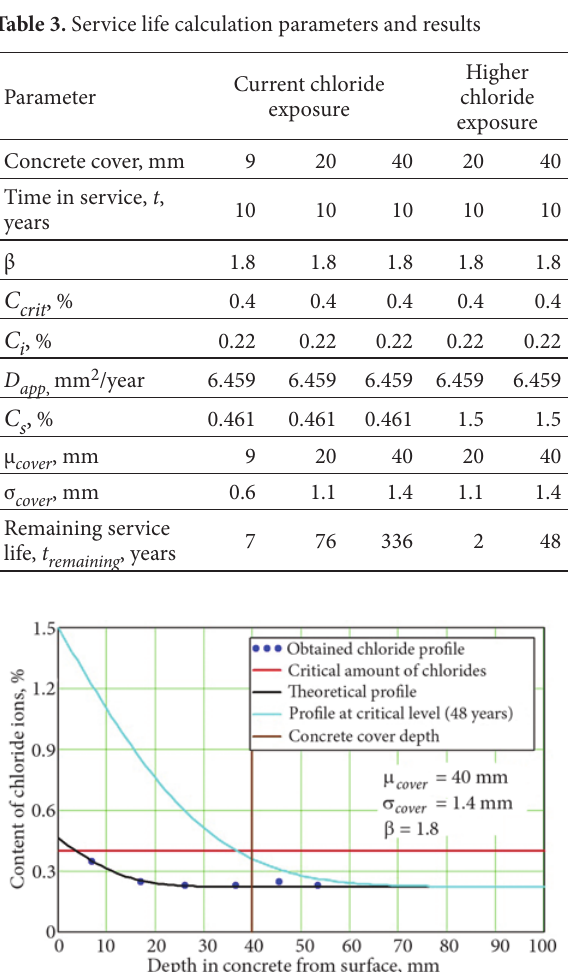
fig. 20. Calculated chloride profile for 40 mm concrete cover